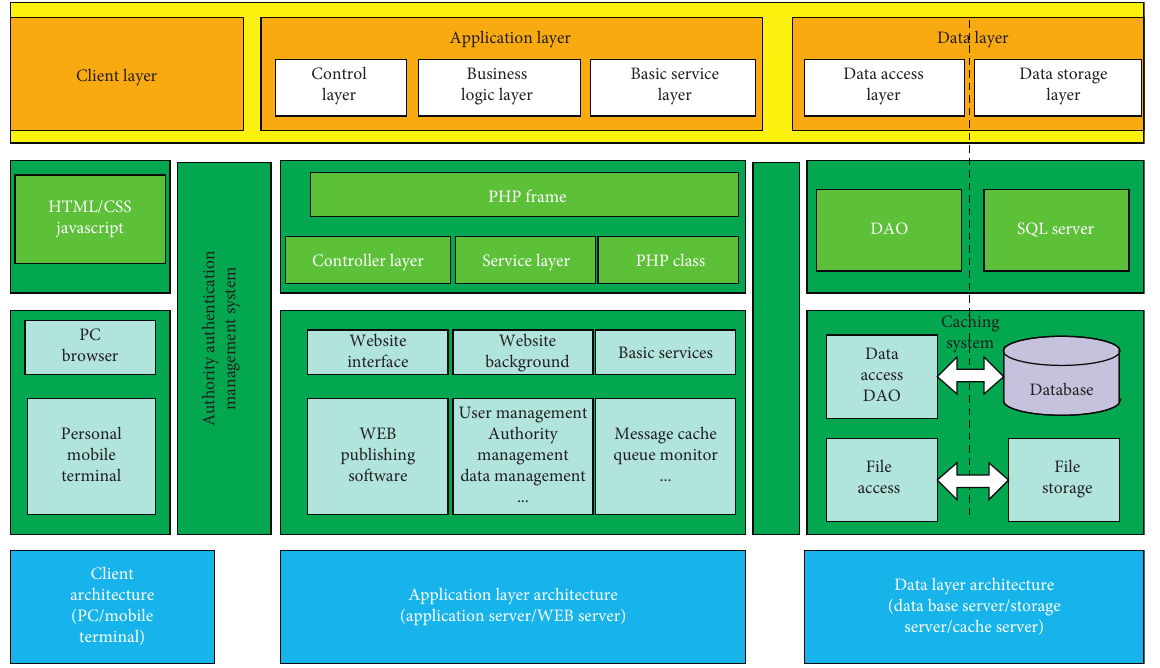
Figure 12: Architecture diagram of the cloud service platform